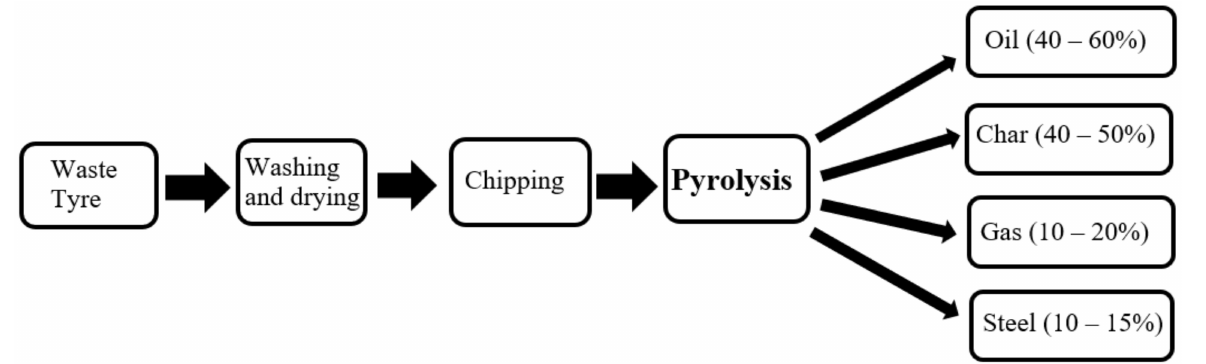
Figure 3. Waste tyre pyrolysis